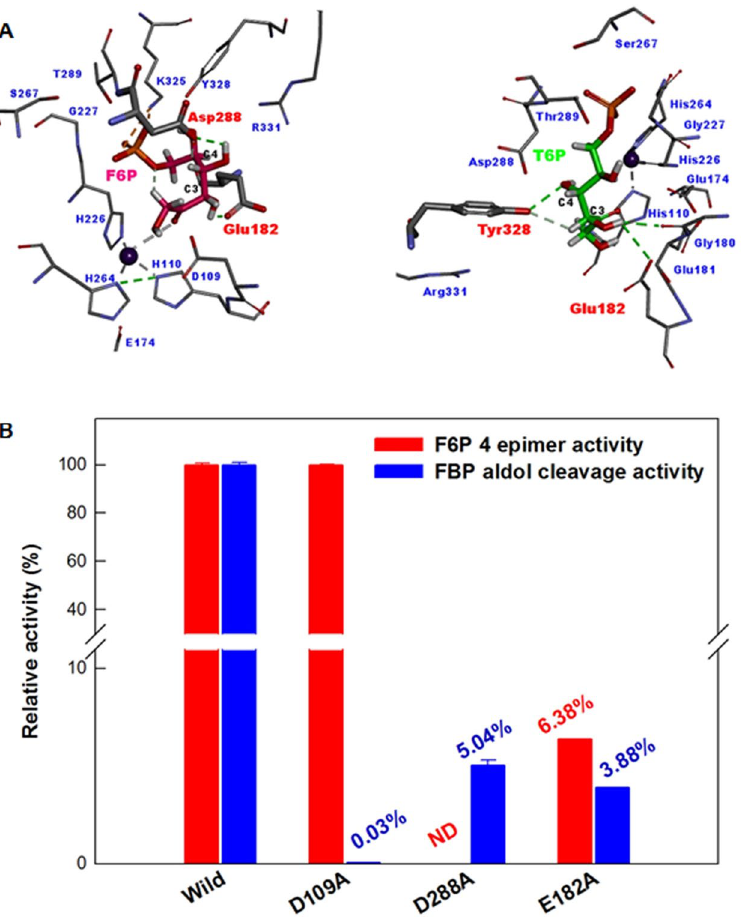
Figure 3. ( A ) Docking model of FbaA with F6P, T6P, and catalytic residues. They represent pink, green, and red colors, respectively. Green dashed lines represent interactions between the substrates and catalytic residues. Grey dashed lines represent interactions with Zn 2 + . ( B ) Aldol cleavage and 4-epimerization activities of the wild-type and catalytic residue variant FbaAs from E. coli . Asp288 mediate aldol cleavage via iraction with FBP, whereas Glu182 and Asp288 mediate 4-epimerization via interaction with F6P. Data represent the means of three experiments and error bars represent standard